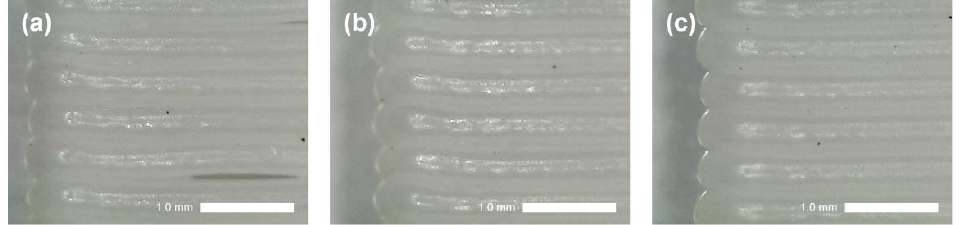
Figure 3. Optical microscope images of 3D-printed junctions printed with a layer height of 0.40 mm ff erent extrusion ratios of ( a ) k = 0.85, ( b ) k = 0.95, and ( c ) k = and different extrusion ratios of ( a ) k = 0.85, ( b ) k = 0.95, and ( c ) k = 1.05. and di